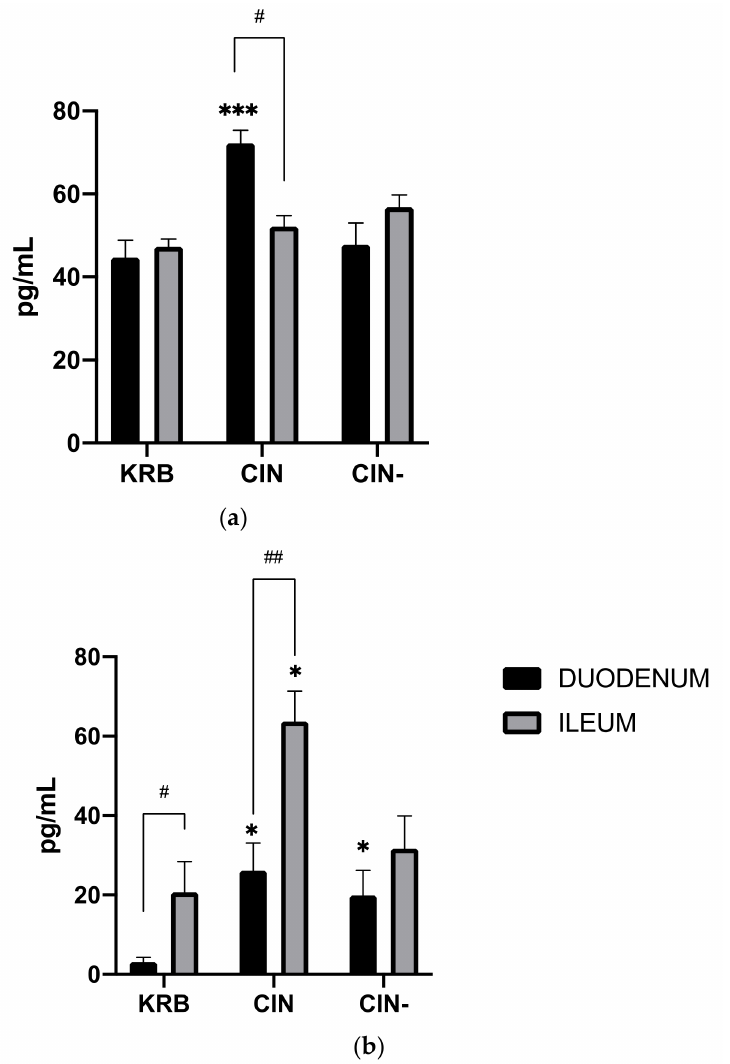
Figure 3. Effect of control KRB buffer (KRB), cinnamaldehyde (200 µ mol L − 1 , CIN) and cinnamalde- nificant differences compared to control (KRB) within the same intestinal site are indicated with asterisks: * p < 0.05, *** p < 0.001. Significant differences between intestinal sites within the same treatment are indicated with a hash: # p < 0.05, ## p < 0.01. n = 6, error bars express the